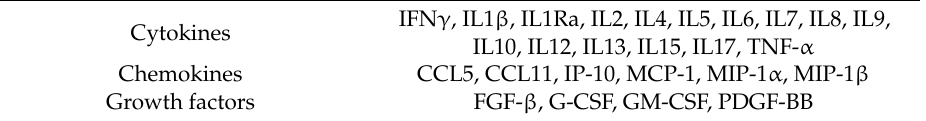
Table 1. List of serum inflammatory biomarkers assayed by multiplex